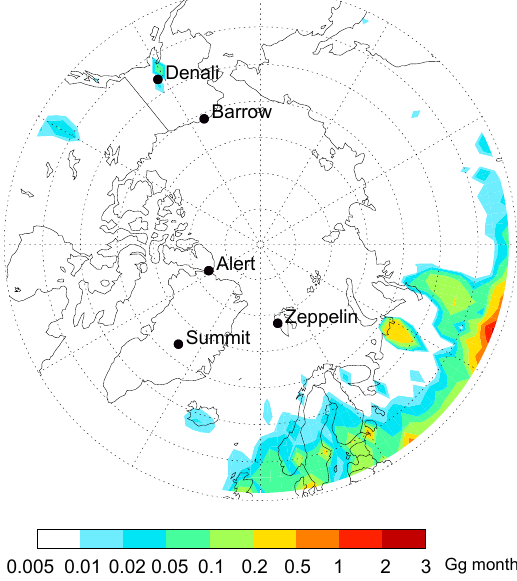
Figure 1. BC emissions (Ggmonth − 1 ) in the Arctic for April. Solid circles are the surface sites: Denali, AL, USA (63.7 ◦ N, 149.0 ◦ W; 0.66kma.s.l.), Barrow, AL, USA (71.3 ◦ N, 156.6 ◦ W; 0.01kma.s.l.), Alert, Canada (82.3 ◦ N, 62.3 ◦ W; 0.21kma.s.l.), Summit, Greenland (72.6 ◦ N, 38.5 ◦ W; 3.22kma.s.l.), and Zep- pelin, Norway (79 ◦ N, 12 ◦ E; 0.47kma.s.l.). Data are from Bond